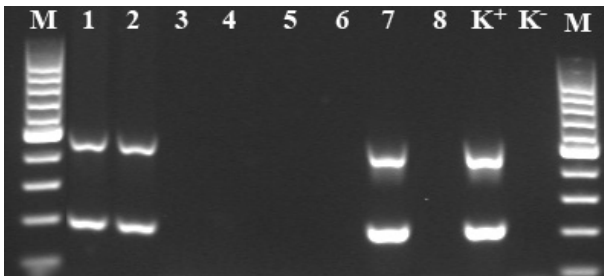
Figure 1. Detection of Pseudomonas syringae pv. actinidiae in bulk fruit samples by duplex-PCR. K - : negative control (water); lanes 1 to 8: bulk-fruit samples; K + : bacterial suspension (5×10 7 cfu mL -1 ) of Pseudomonas syringae pv. actin- idiae CRA-PAV 1530; M: molecular marker 100 bp DNA Ladder Plus (Fermentas,